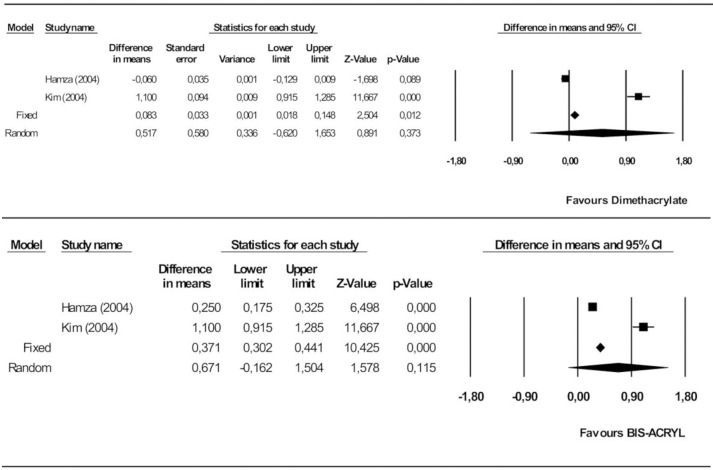
Forest plot of fracture toughness.Dimethacrylate vs. monomethacrylategroups (Fig 4A), Bis-acryl vs. PEMA (Fig 4B).